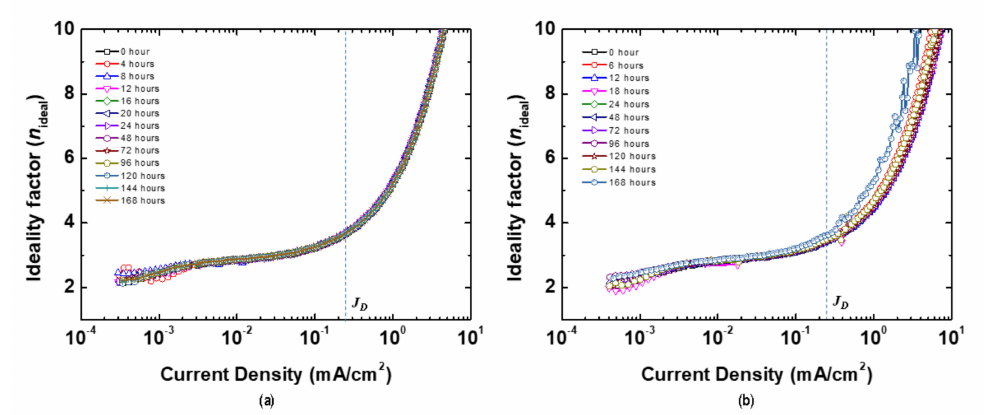
Figure 5. Variations of n ideal at J D for the constant current stresses at ( a ) 2.5 × J D and ( b ) 15 × J D